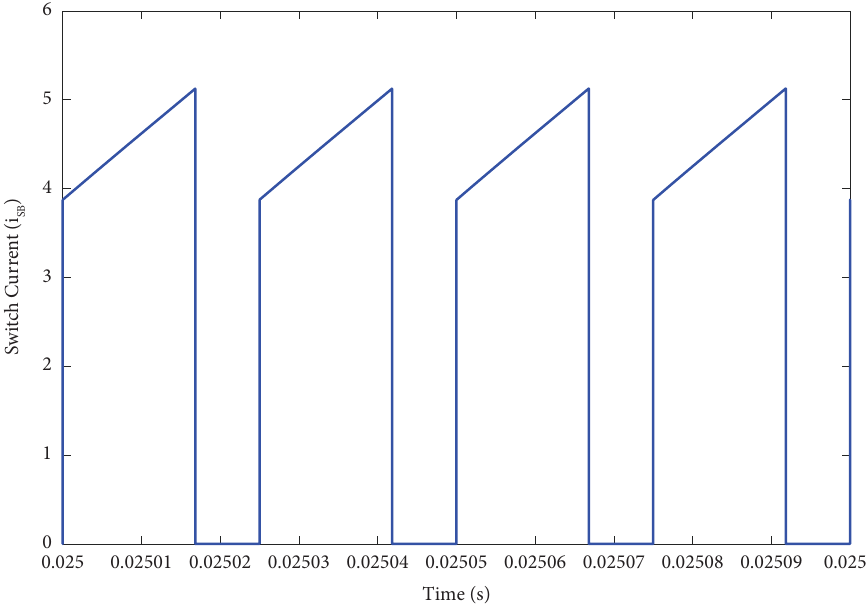
Figure 12: Te switch S B simulated current waveform.